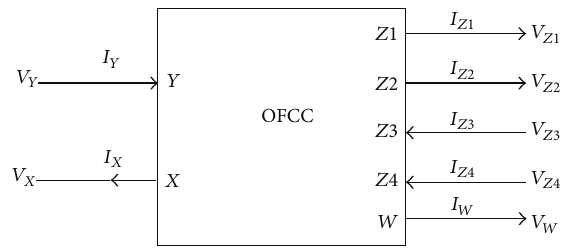
Figure 1: Circuit symbol of OFCC.